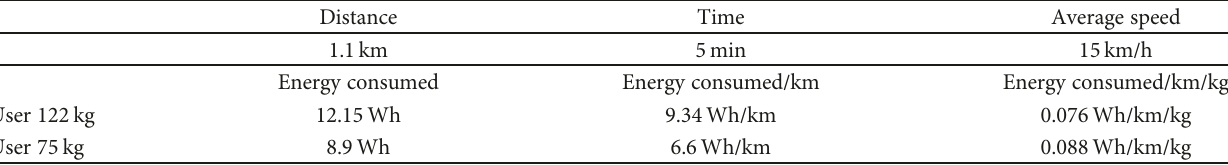
Table 4: Electric consumption from two di ff erent users over the same speci fi c route.